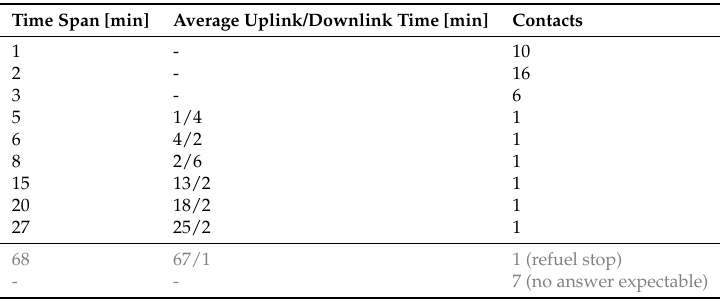
Table 6. Query–Response time: Time interval between sending a query and receiving the corresponding answer (email to email). Gray values were not taken into account for further